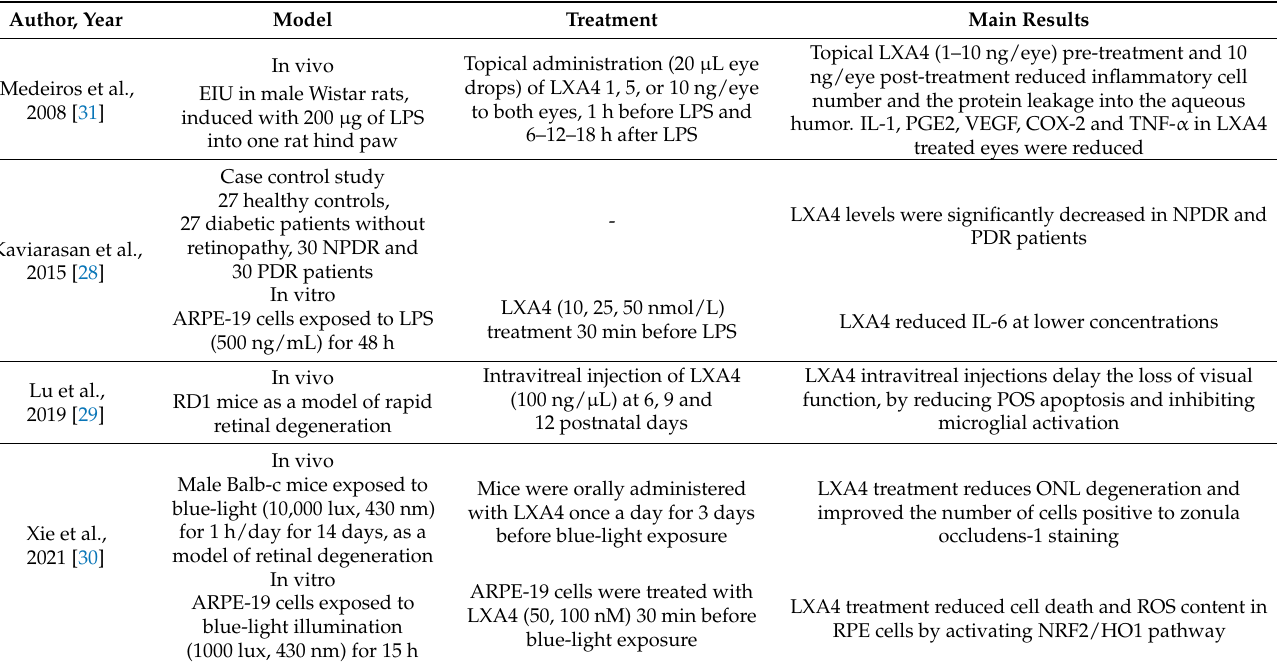
Table 1. Lipoxins and retinal